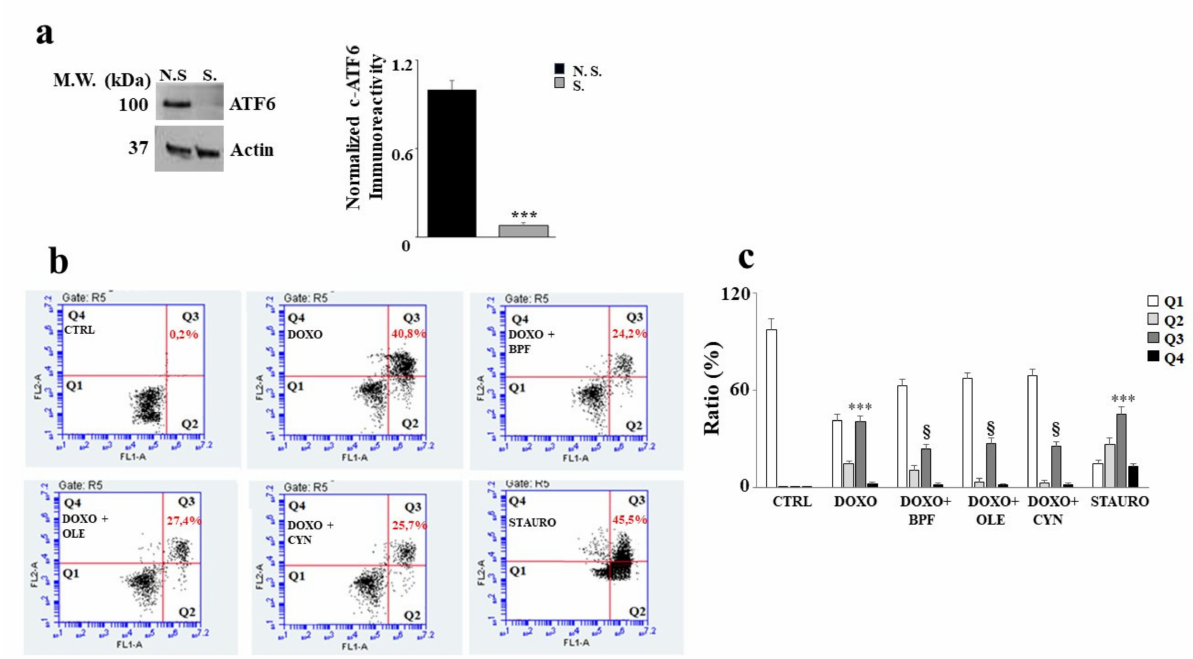
Figure 6. Silencing of ATF6 induces apoptotic cell death. Representative Western blot and quantification graph related to ATF6 silencing (panel a ). N.S refers to cells that were not silenced, while S. refers to transfected and silenced cells. Representative dot plot of the cytometric analysis of three independent experiments involving Annexin V/PI staining (panel b ). Each plot is divided into four quadrants (Q1, Q2, Q3 and Q4). Q1 refers to Annexin V negative/PI negative cells. Q2 refers to Annexin V positive/PI negative cells (apoptosis). Q3 refers to Annexin V positive/PI positive cells (apoptotic secondary Necrosis); Q4 refers to Annexin V negative/PI negative cells (advanced necrosis). Quantification graph showing mortality in cells silenced for ATF6 and treated with 1 µ M of DOXO alone for 6 h, or pre-treated with BPF (5 µ g/mL), OLE (1 µ M), or CYN (1 µ M) for 24 h and then with DOXO for 6 h (panel c ). Cells treated with stauro-sporine (STAURO) were used as positive controls. The values of three independent experiments are expressed as means ± standard deviations. *** denotes p < 0.001 vs. CTRL; § denotes p < 0.05 vs. DOXO. The Analysis of Variance (ANOVA) was followed by the Tukey–Kramer comparison